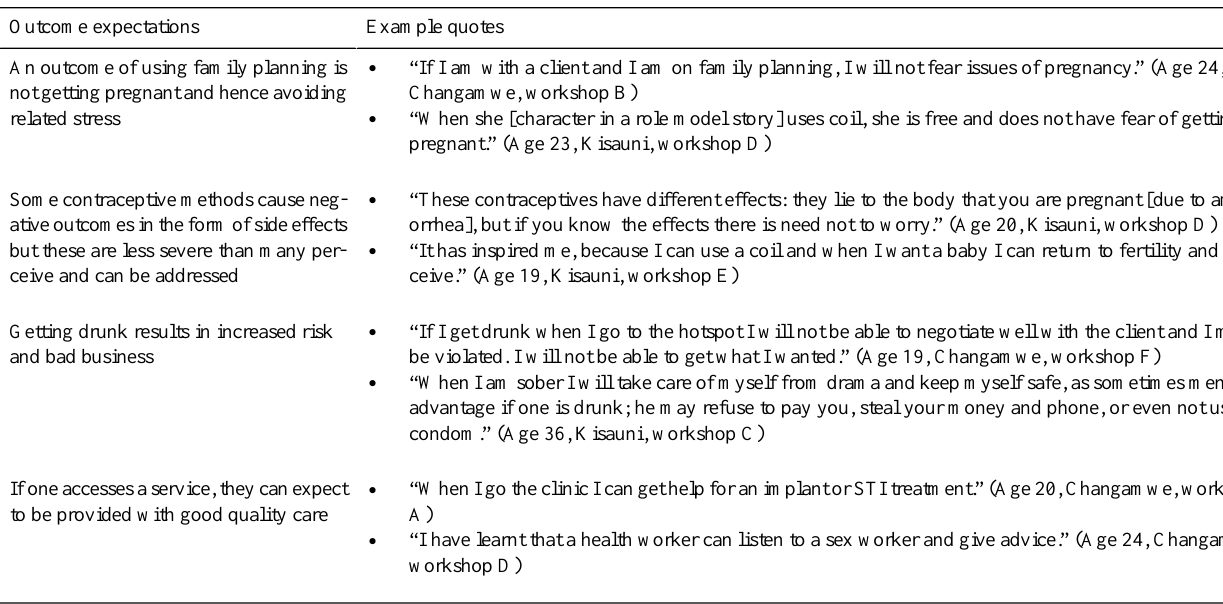
Table 4. Outcome expectations raised by workshop participants and corresponding